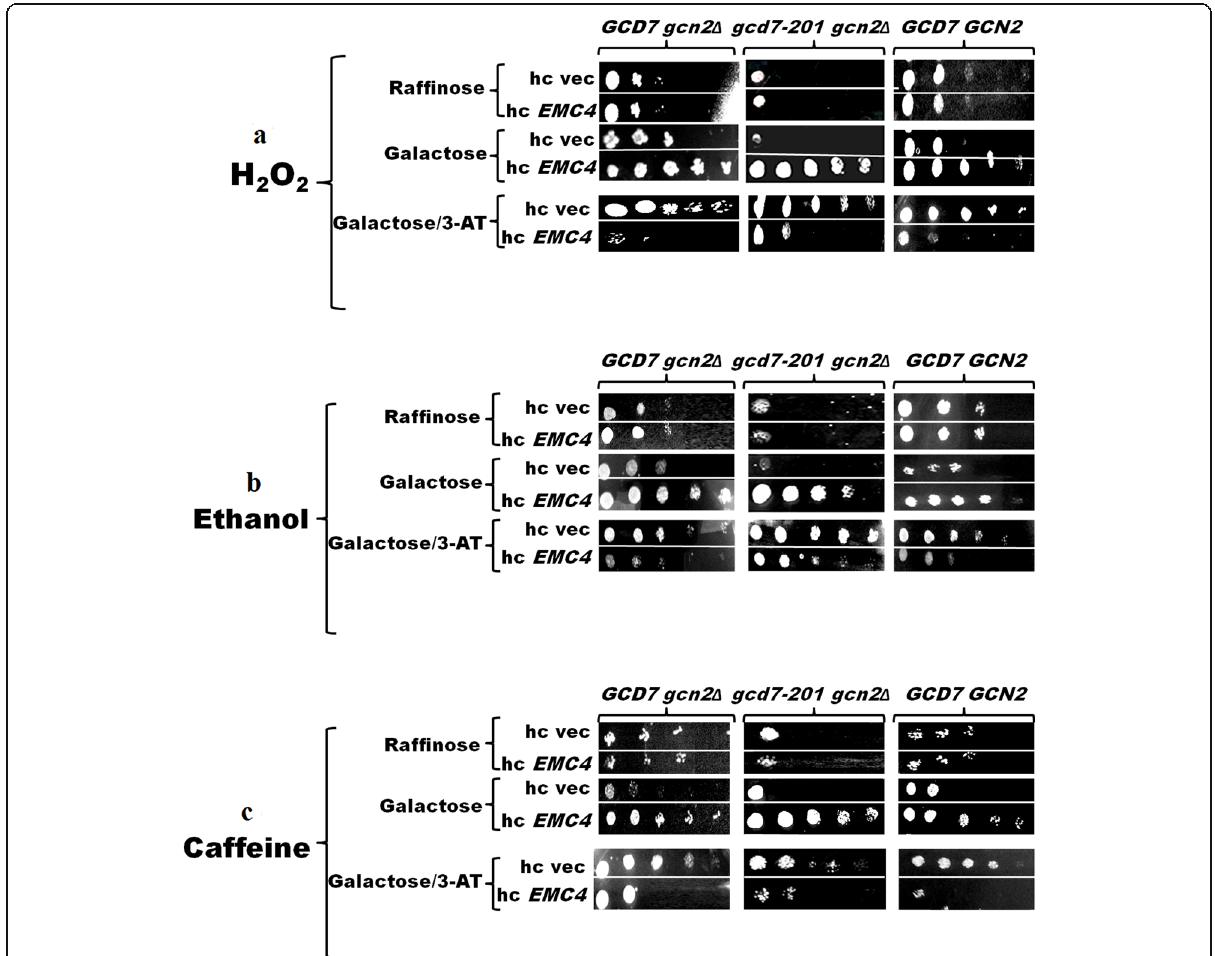
Fig. 4 Spot assay to test the effect of H 2 O 2 , ethanol, and caffeine on the growth of eIF2B mutants. Hydrogen peroxide, ethanol, and caffeine spot assays were performed with gcd7-201 gcn2 Δ , GCD7 gcn2 Δ , and GCD7 GCN2. Ten-fold serially diluted transformants harboring empty hc, vector pEG (KG), or hc/ EMC4 were spotted on SC-Ura or SC-Ura/3-AT agar plates supplemented with ( a ) H 2 O 2 (4 mM), ( b ) ethanol (10%), and ( c ) caffeine (30 mM) in the presence of either raffinose or galactose. Cultures were incubated for 2 days at 30